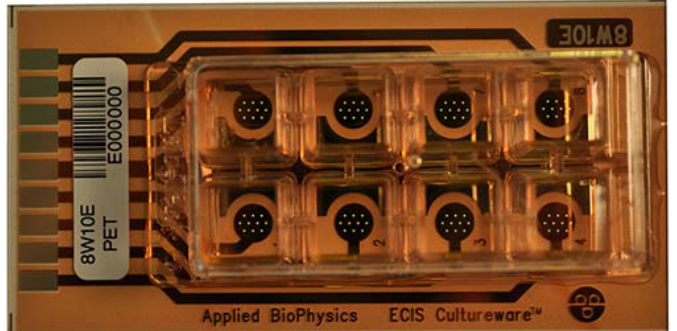
Figure A1. Applied BioPhysics electrodes used.